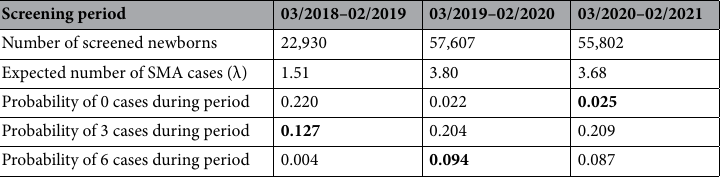
Table 3. Poisson probability of case occurrence in Southern Belgium based on annual periods. Bold values correspond to the number of SMA cases actually identified during the designated